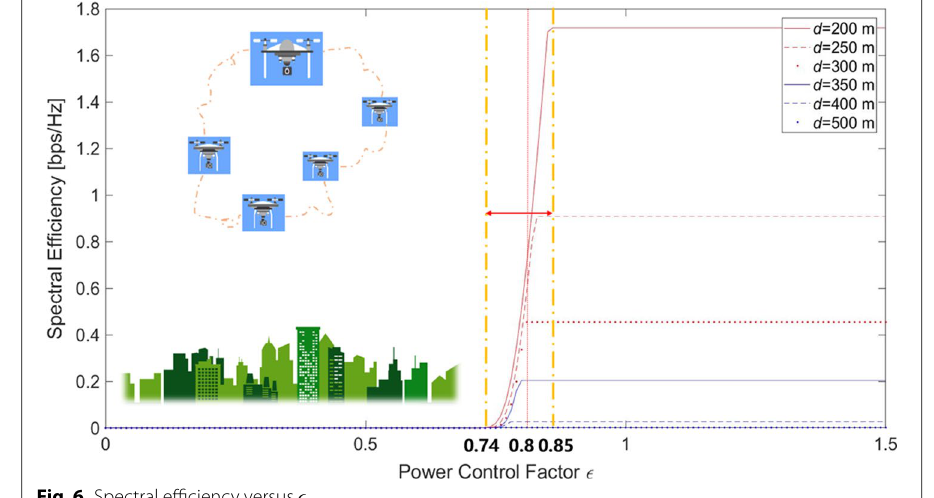
Fig. 6 Spectral efficiency versus ǫ